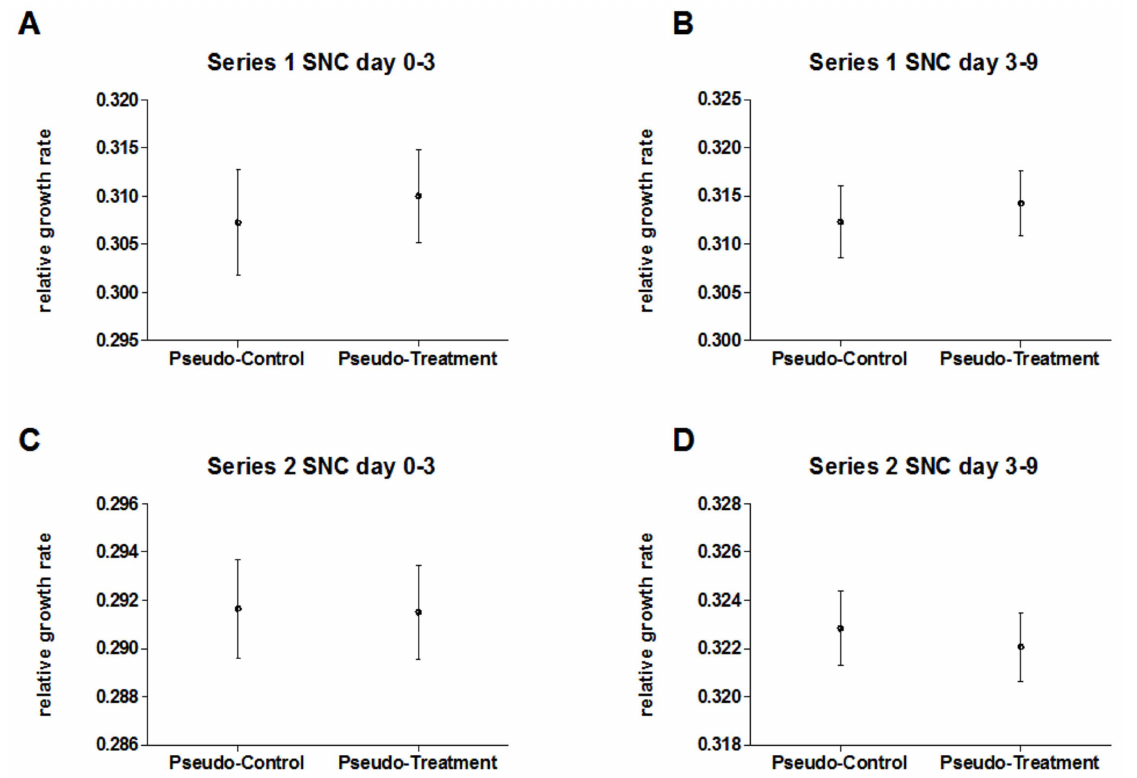
Figure 4. Mean relative growth rates ( ± 95% CI) of duckweed of five SNC experiments in each series (1/2) for numerically pooled data of pseudo-treatment (n = 200) and pseudo-control group (n = 170) for ( A ) series 1 (early time period, day 0–3); ( B ) series 1 (late time period, day 3–9); ( C ) series 2 (early time period, day 0–3); and ( D ) series 2 (late time period, day